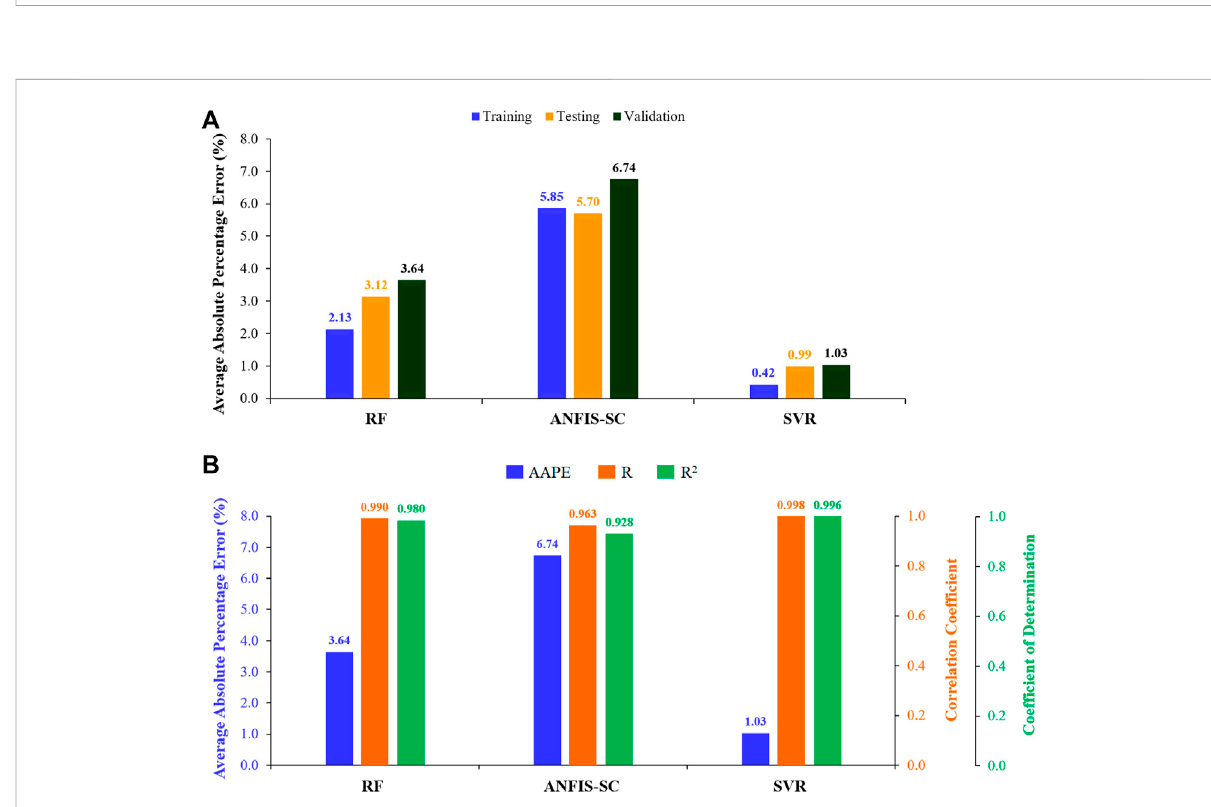
FIGURE 9 Comparison of the prediction accuracy of the optimized RF, ANFIS-SC, and SVR models; (A) AAPE for the training, testing, and validation data; and (B) the AAPE, R, and R 2 for the validation data of Well-C.